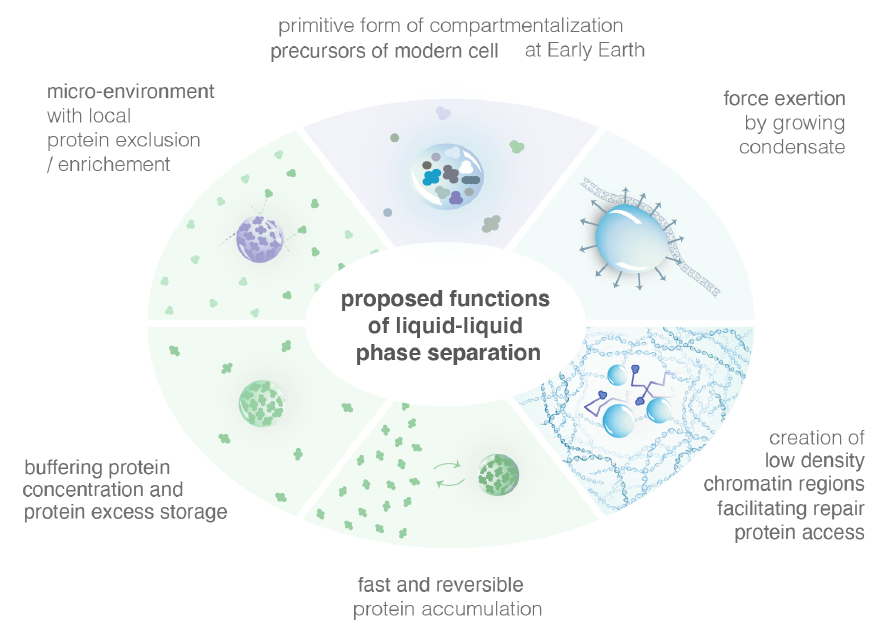
Figure 4. Illustration of several proposed functions of Figure 4. Proposed algorithm flow diagram Since the captured frames are noisy, degraded, and have artifacts due to environmental surroundings, a Gaussian kernel is utilized to suppress these artifacts and to keep strong edges representing potential highway lane sides. A canny edge detector is employed to detect candidate edges from blurred images, followed by connected components analysis to suppress unwanted edges in small areas. Then, the Hough transform is applied to detect possible lines in the edge image. Vertical lines whose angles are less than 2 o are suppressed. It’s assumed that the possible lanes will not be vertical lines since these vertical lines may account for other objects within the scene, such as light poles. Applying Hough transform to the image results in a feature space of two parameters, namely, ρ and θ . ρ represents the normal from the origin to the detected lines while θ represents the inclination to x -axis. Next, fuzzy C-mean is applied to Hough space features to cluster the possible detected Hough lines using the two features, ρ , and θ . The number of clusters is set empirically to 4 clusters. Since the detected clustered lines may be represented as broken segments near each other, curve fitting is employed to fit a cluster of detected broken segments into a unique single line. Several 1D curve fitting techniques are tested, including linear and higher order polynomials, exponential, Gaussian, and cubic spline models. Empirically, it is found that the linear polynomial model provides the best results. Finally, a raster scan is utilized across the image overlaid by fitted curves. These curves are used as guidelines to define the masked areas. 2.2. Foreground Segmentation The foreground segmentation process identifies moving vehicles through the highway image scene. This stage is a crucial step in the proposed algorithm since it is required to extract vehicles with high accuracy and low computational time to make the system suitable for real-time implementations. Plenty of approaches have been developed in the literature related to foreground segmentation. Of these approaches are the robust low-rank and sparse matrix decomposition in which a low-rank matrix represents the background image and a sparse matrix represents the foreground objects [51]. These techniques prove to achieve high accuracy and real-time implementations. Sobral et al. [52] have reported several Low-rank decomposition algorithms for background extraction from videos, and they ranked those algorithms in terms of their computational time.